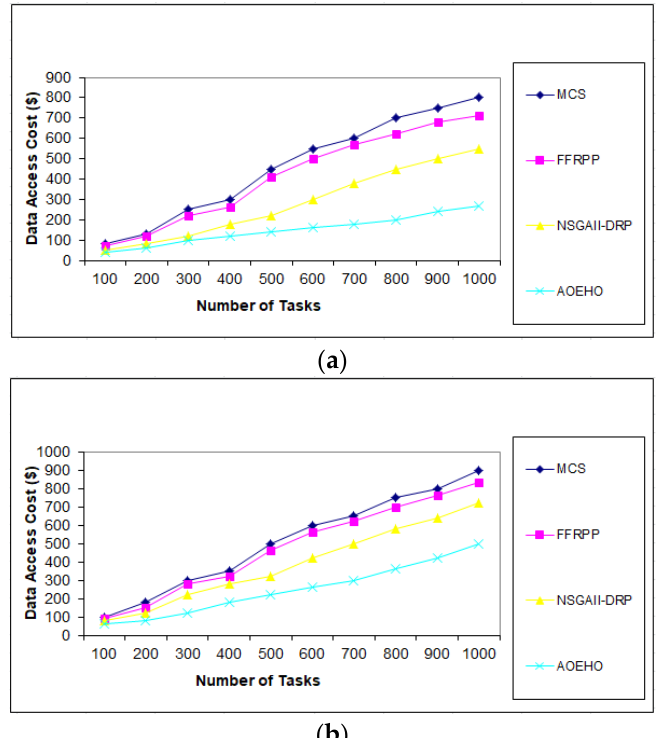
Figure 3. Cost number of tasks and cost = 1000 tasks. ( a ) Size of data replication = 64 MB. ( b ) Size of data replication = 320 MB.